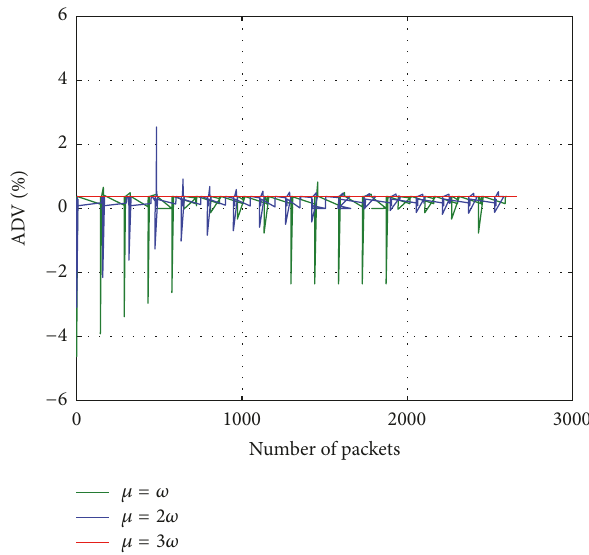
Figure 7: Average delay variance (ADV) comparison among the link of different remaining bandwidth.